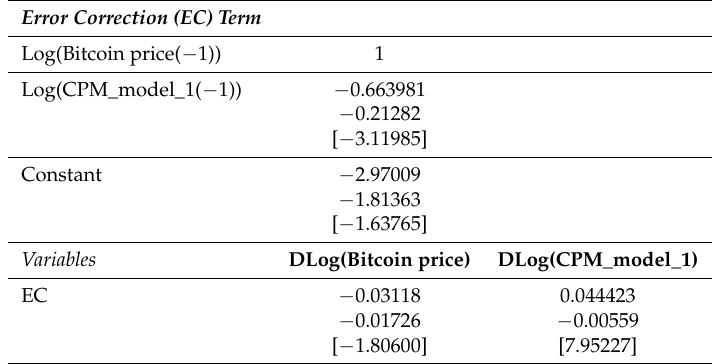
Table A4. VECM(0) for the variables Log(Bitcoin price) and Log(CPM model 1). Second sample: 11/12/2017–24/02/2020.